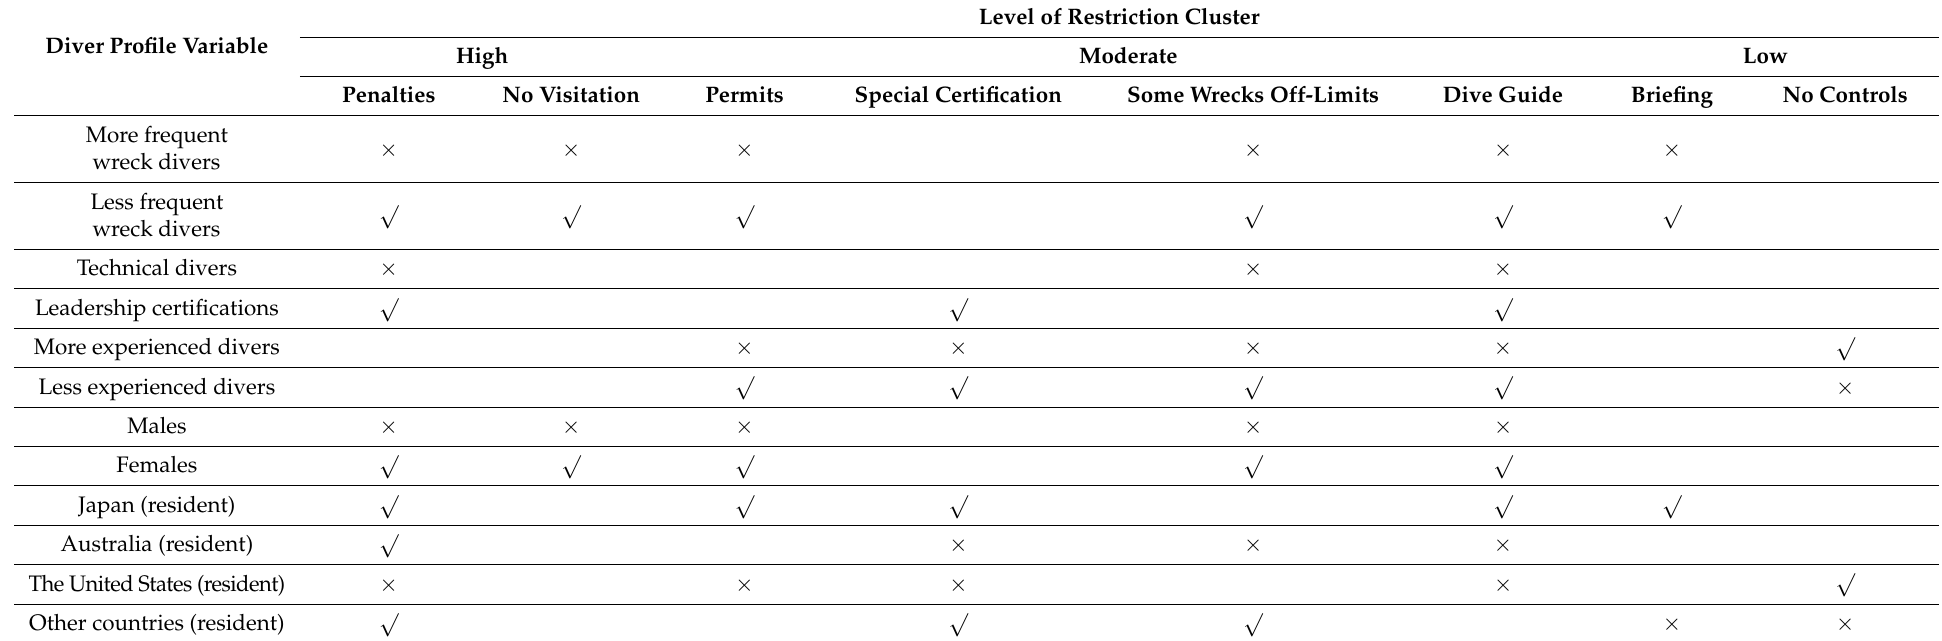
Table 2. Attitudes to management controls: summary of key differences (from [37] (p. 304)).